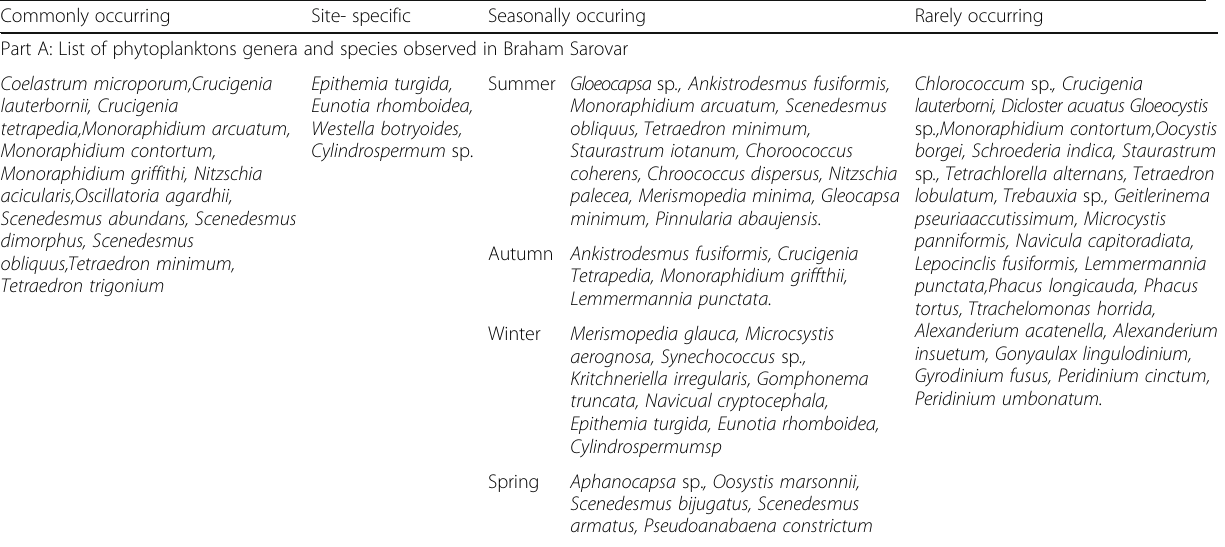
Table 4 Phytoplankton -map (P-maps) of Braham Sarovar Commonly